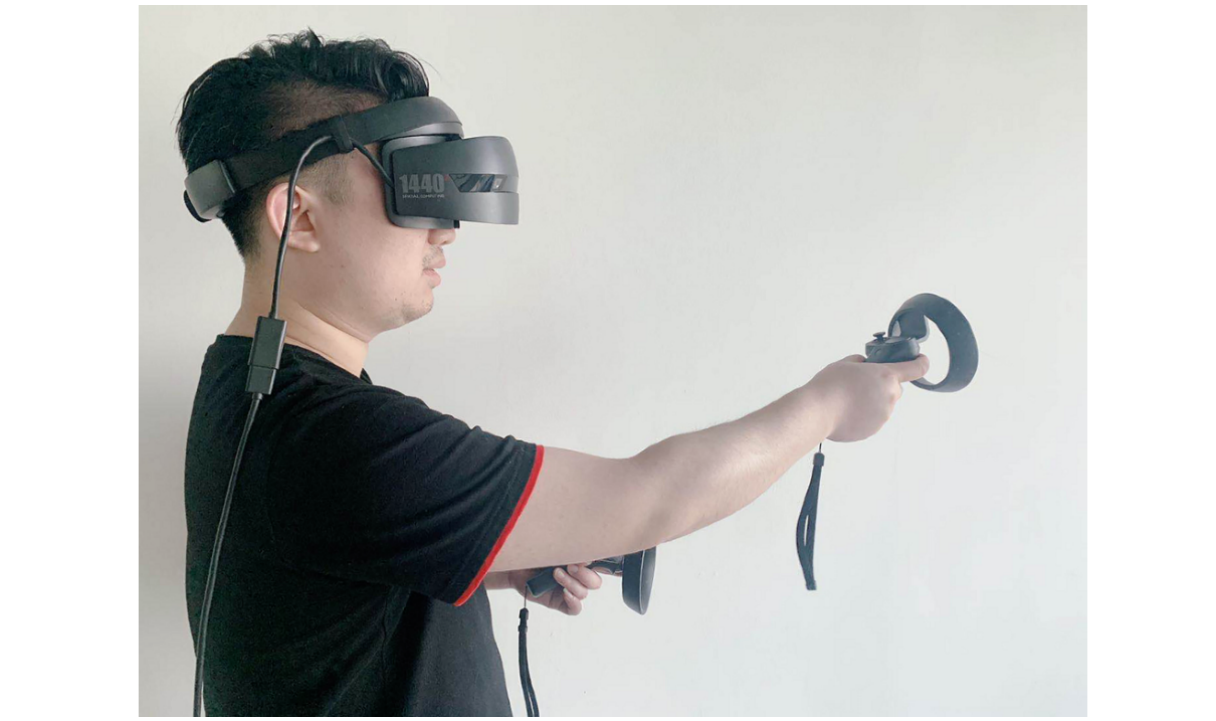
Figure 1. Head-mounted display and body motion